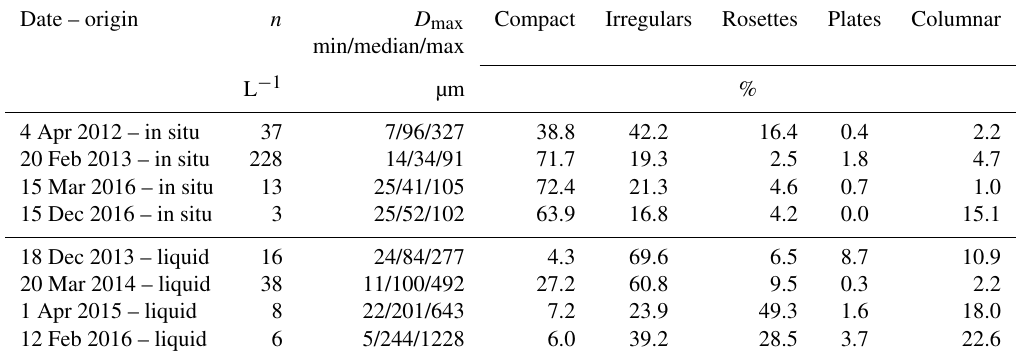
Table 2. List of days, mean number concentration n , mean particle D max , and relative number (in %) of particles in different shape groups. Date – origin n D max Compact Irregulars Rosettes Plates Columnar min/median/max L − 1